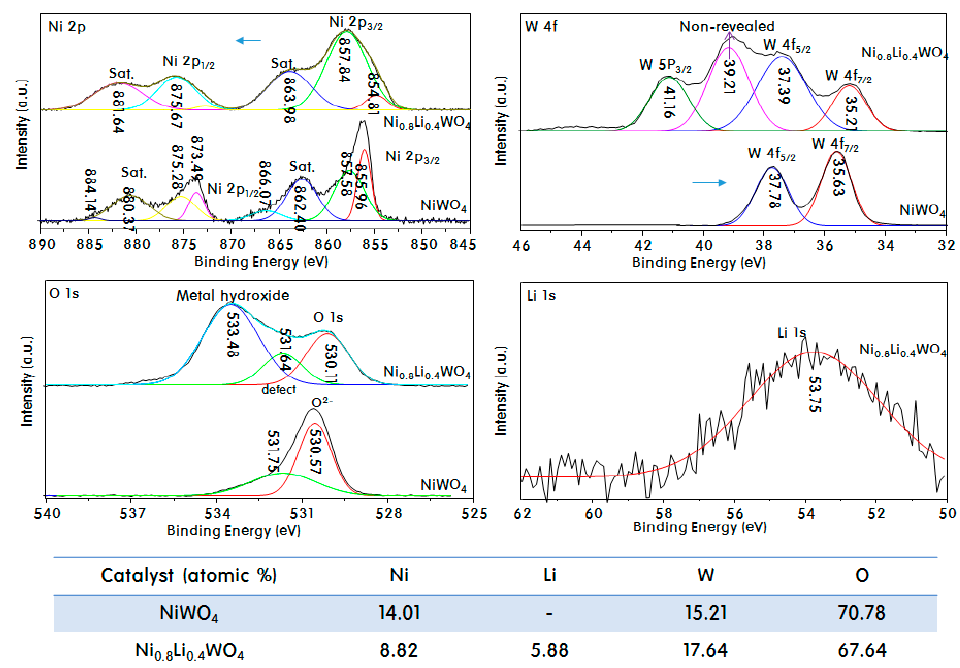
Figure 2. Ni 2p, W 4f, O 1s, and Li 1s XPS spectra of NiWO 4 and Ni 0.8 Li 0.4 WO 4 particles, and elemental compositions.